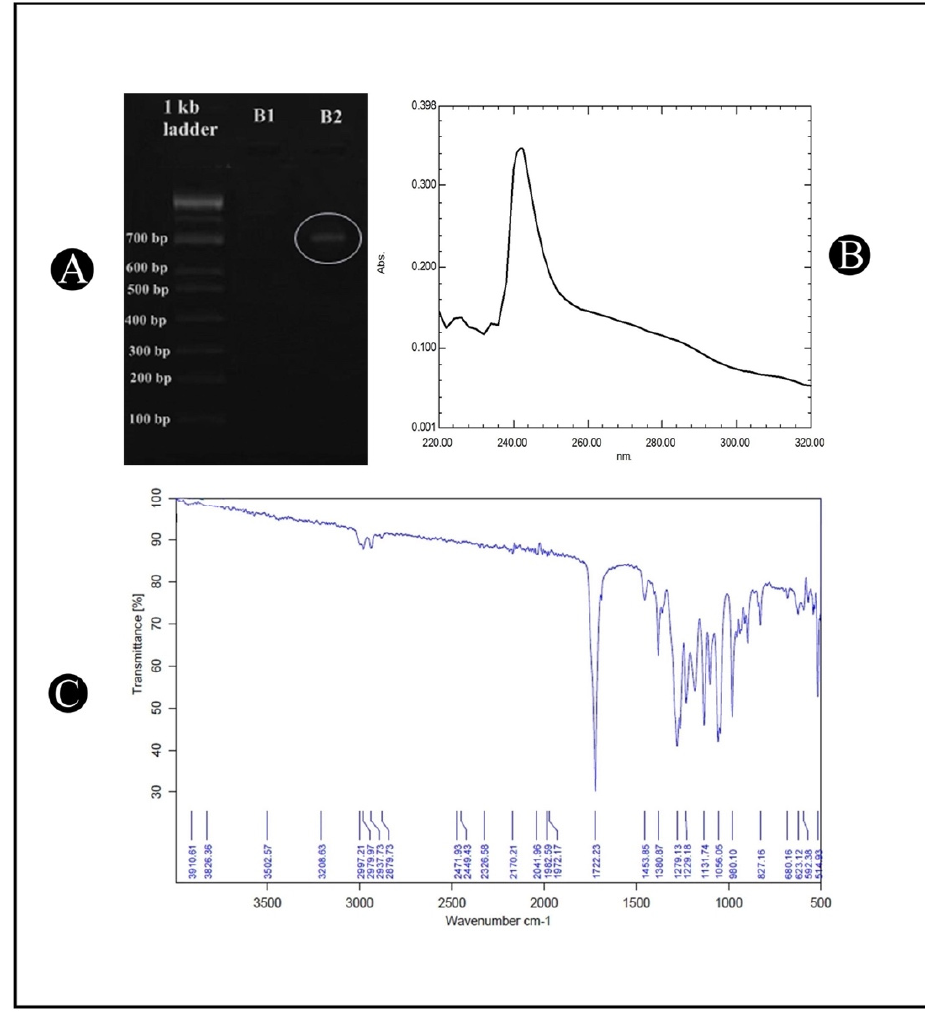
Figure 2. ( A ) Amplification of phbB gene in A. indicus strain B2 by PCR amplification followed by agarose gel electrophoresis; ( B ) UV–Vis-spectrophotometer-scanning spectrum of extracted PHB from A. indicus strain B2; ( C ) FTIR analysis of extracted PHB from A. indicus strain B2.